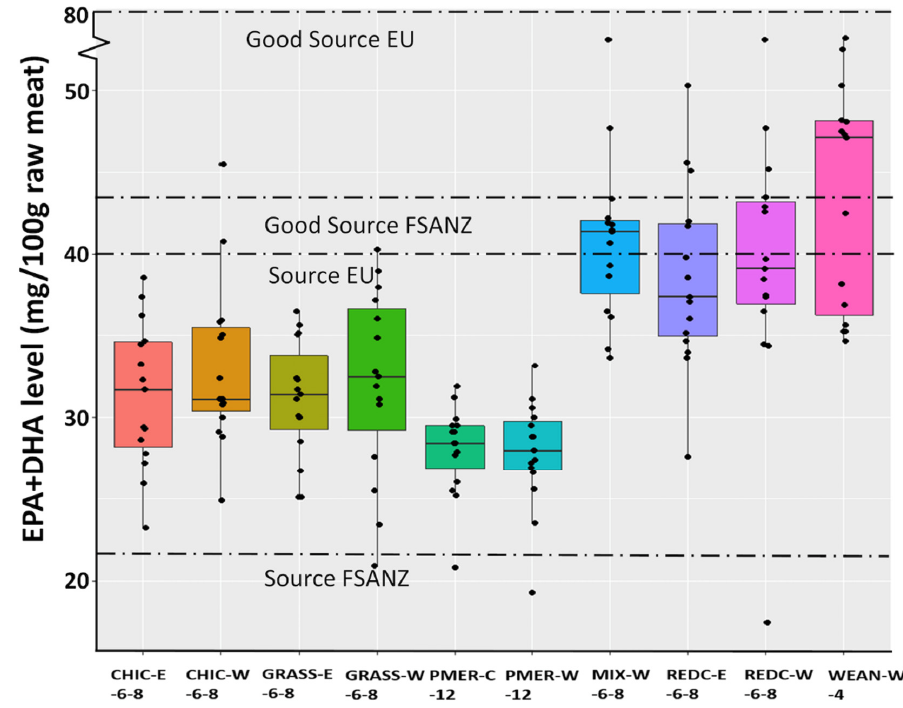
Figure 1. Box plot of EPA + DHA content in Longissimus thoracis for each lamb group. Horizontal dashed lines indicate minimum values for meat to be considered as a ‘source’ of EPA + DHA (22 mg/100 g muscle) or a ‘good source’ (44 mg/100 g muscle) according to Food Standards of Australia and New Zealand (FSANZ), and minimum values to be considered as a ‘source’ (40 mg/100 g muscle) or a ‘good source’ (80 mg/100 g muscle) of EPA + DHA fatty acids according to the Commission Regulation of European Union (EU).